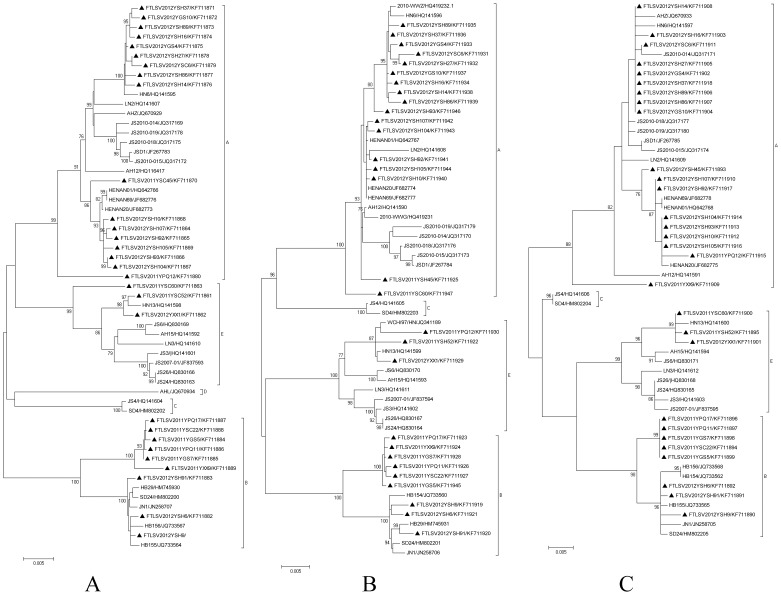
Phylogenetic analysis of FTLSV strains isolated from Henan Province during 2011 and 2012, compared with other bunyaviruses.The phylogenetic tree was constructed by using the maximum likelihood method with the MEGA5 software. The reliability values indicated at the branch nodes were determined using 1,000 bootstrap replications. Isolated FTLSV strains in 2011 and 2012 from Henan Province were labeled by black solid triangles. Phylogenetic relationship of FTLSV with other bunyaviruses, based on the complete L, M, S segment sequences, are shown in panel A, B, C, respectively.